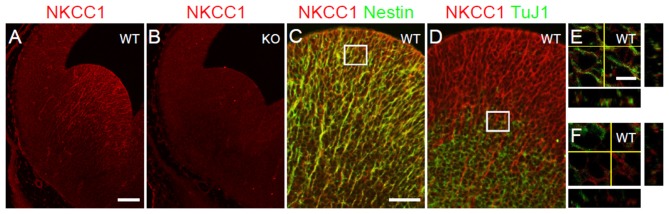
Na-K-Cl cotransporter (NKCC1) is expressed in proliferative zone cells. (A,B) Immunohistochemical staining for NKCC1 in the lateral ganglionic eminence (LGE) of wild-type (WT) (A) and NKCC1 knockout (KO) (n = 6) (B) mice at E12.5. (C–F) Co-labeling of NKCC1 together with nestin (n = 3) (C), and with TuJ1 (n = 3) (D) in E12.5 WT LGE. (C) The merge image shows the co-localization of NKCC1 and nestin. (D) The merge image shows the opposing expression patterns of NKCC1 and TuJ1. High-magnification confocal images of the boxed area in (C,D) are shown in (E,F), respectively. Scale bar 200 μm in (A), 100 μm in (C), 20 μm in (E).